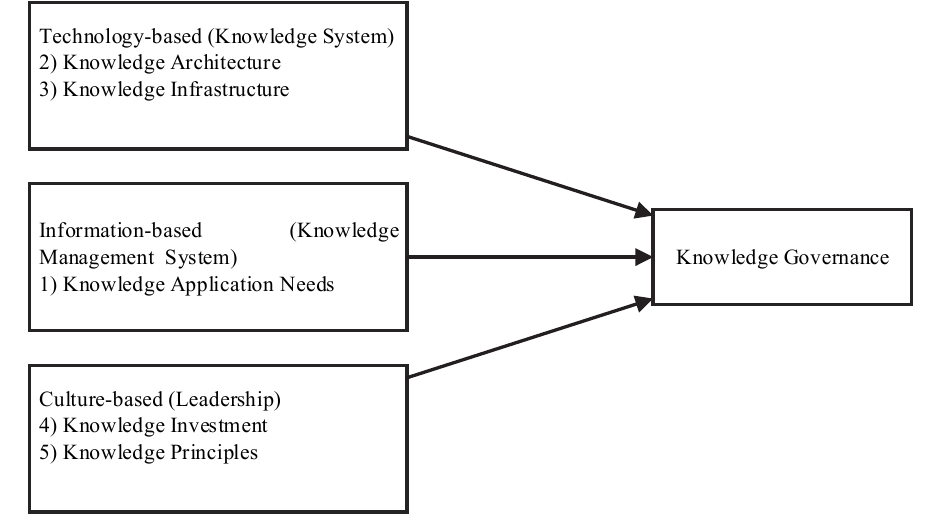
Fig. 3. Knowledge Governance